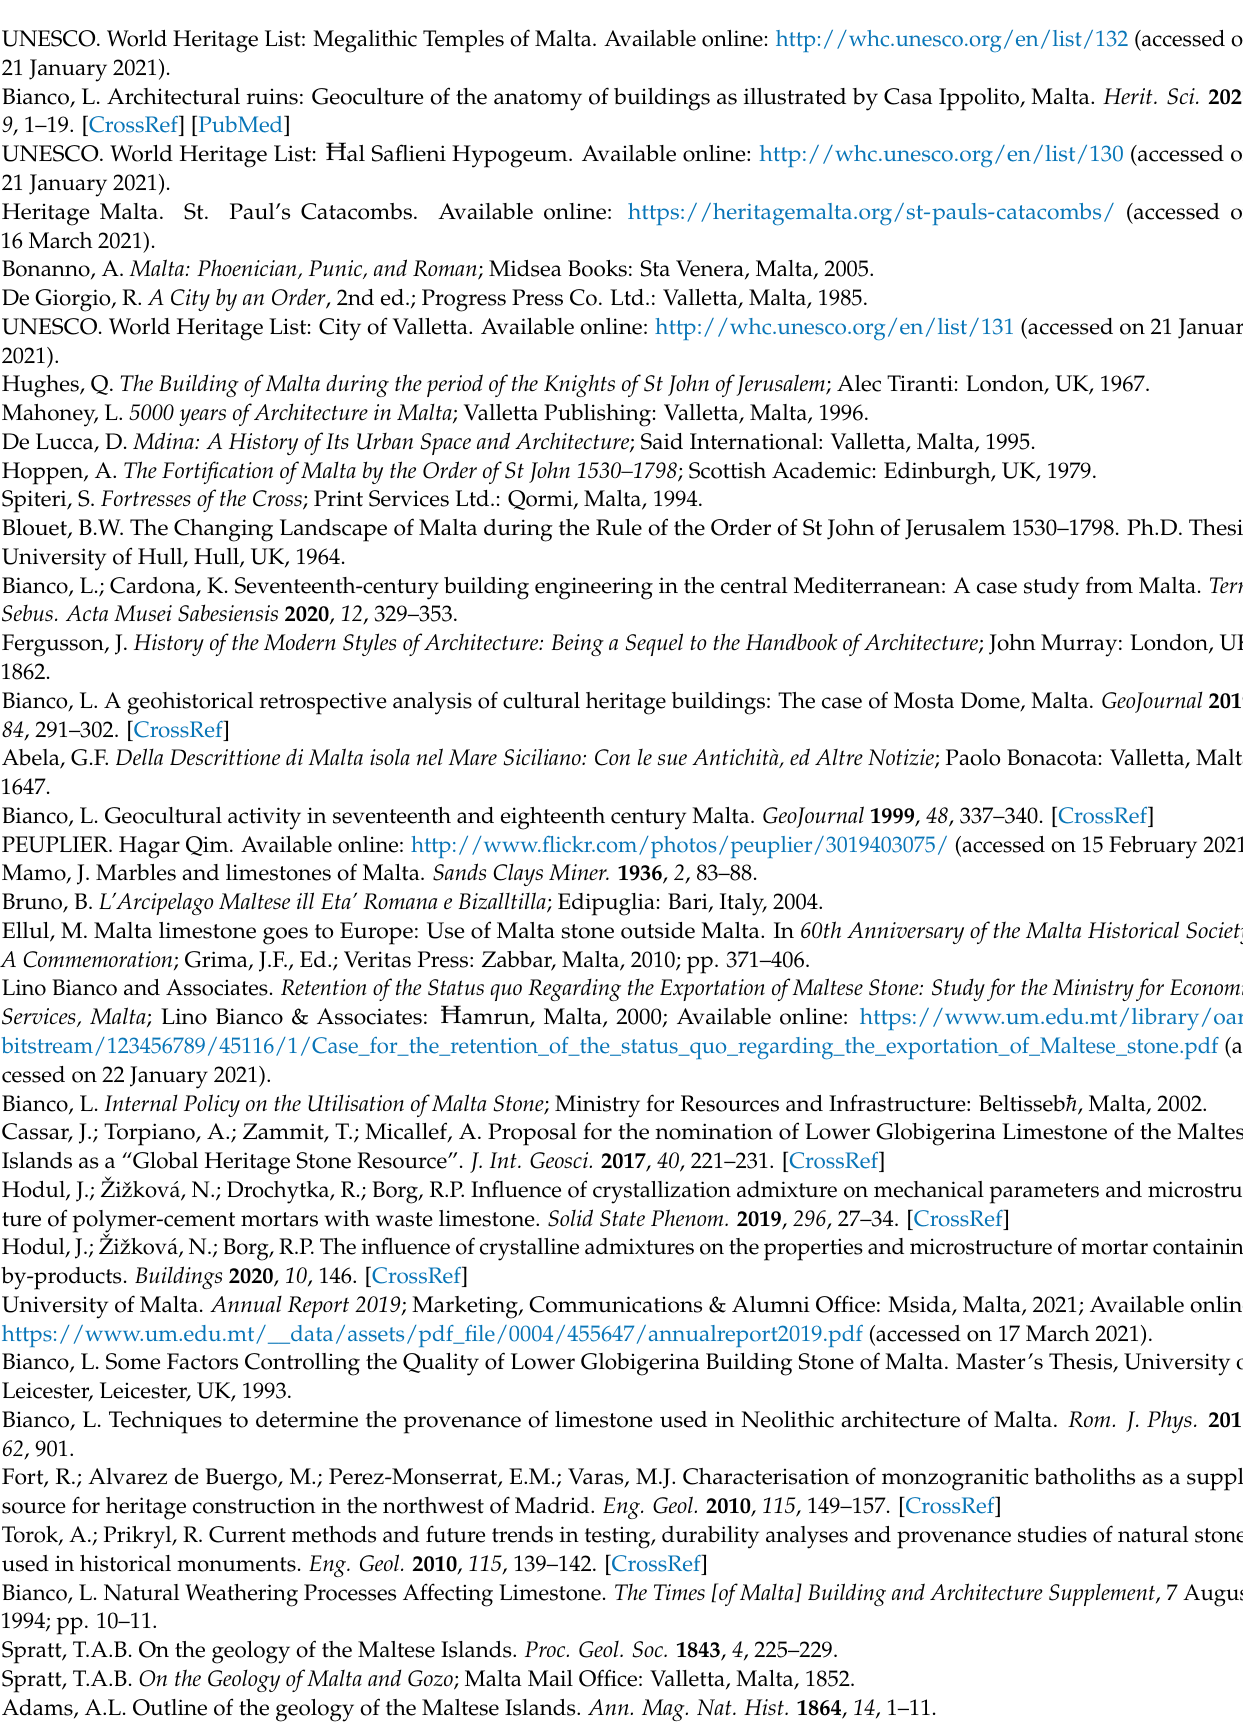
Figure 1. The Maltese Archipelago: ( a ) location with respect to the Mediterranean Basin; ( b ) the main habitable islands; the location of case-studies is also included (© Google